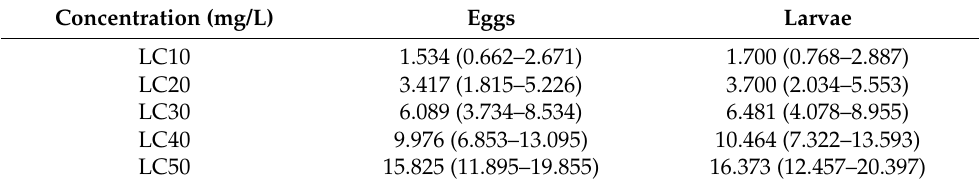
Table 3. The corresponding sublethal concentrations of diflubenzuron against eggs and larvae of T. cinnabarinus .